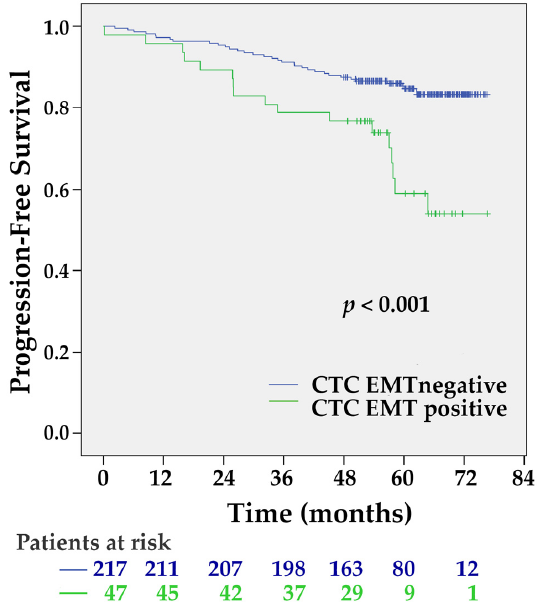
Figure 3. The Kaplan-Meier PFS estimates for circulating tumor cells (CTC) epithelial-to-mesenchymal transition (EMT). CTC EMT positive patients had significantly shorter PFS ( p < 0.001 by the Log-rank